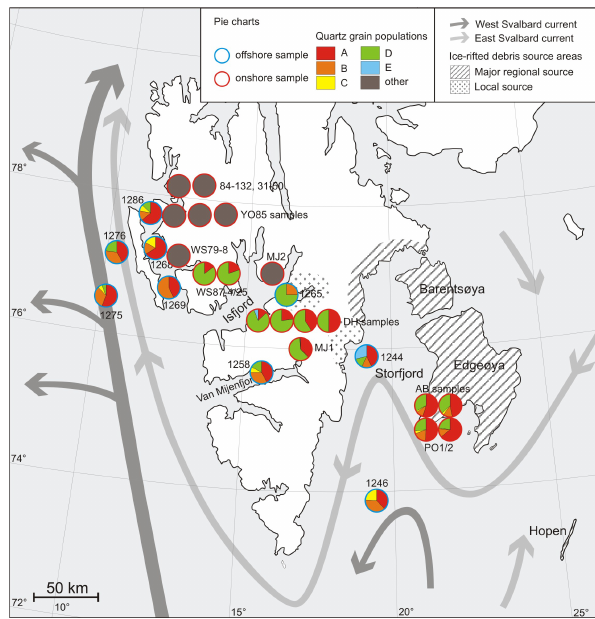
Fig. 5. Map of onshore and offshore samples of Spitsbergen and sur- rounding seas. Each pie chart represents the distribution of quartz grain populations (types A to E and “other”). The pie charts of off- shore samples illustrate the dominance of type A an B grains in al- most all samples, whereas the onshore samples have distinct quartz populations restricted to certain areas. The distribution of quartz populations in the Late Triassic sandstones from Edgeøya resemble most the distribution in offshore samples even though the precision of the percentage of offshore grain populations is poor due to the limited number of accessible